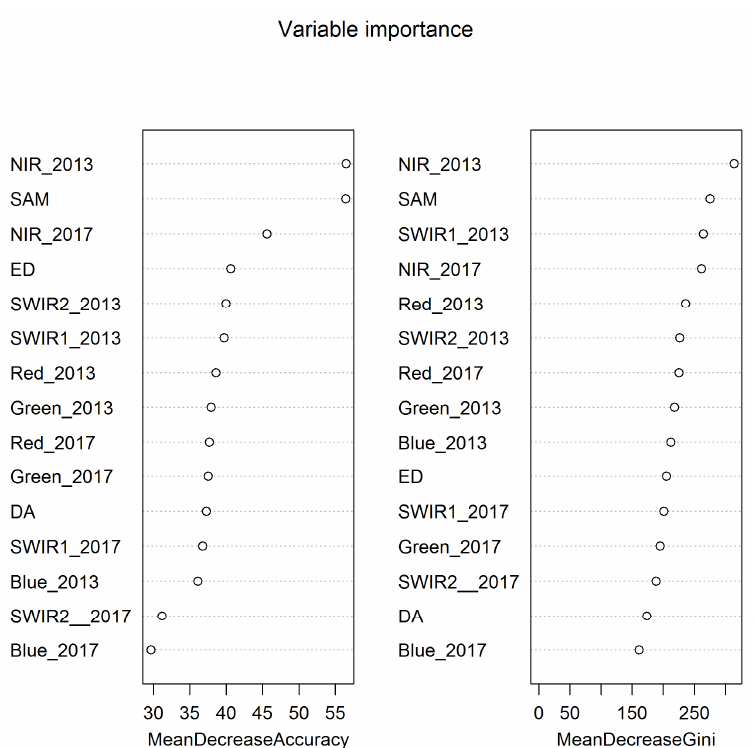
Figure 3. The relative importance of each variable as indicated by Mean Decrease Accuracy and Mean Decrease Gini measures.